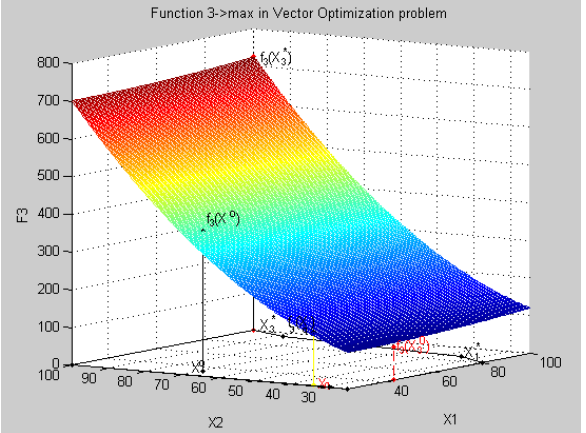
Figure 11. The third characteristic f 3 ( X ) of the technical system in a natural indicator.